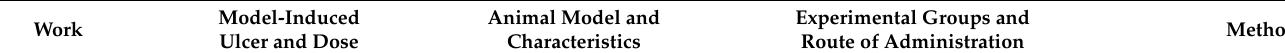
Table 1. Characteristics of each study that complied with the selected characteristics for this